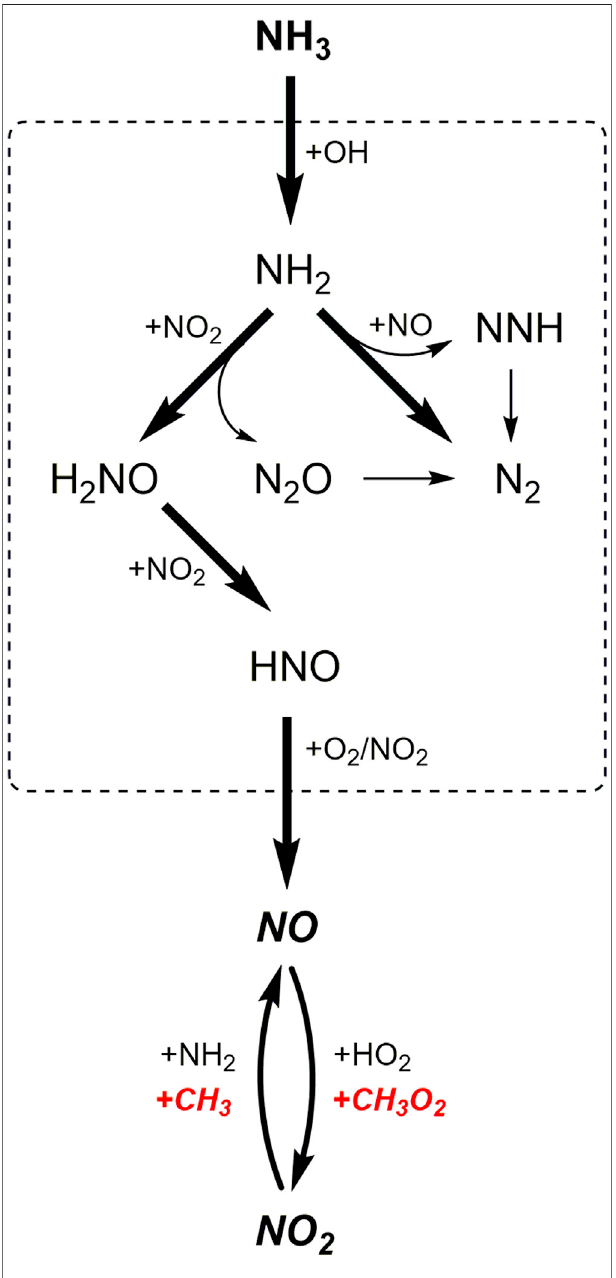
FIGURE 3 | Major reaction paths of NH 3 in the oxidation of GM1, GM2, GM3, GM4, GM5 and GM6.